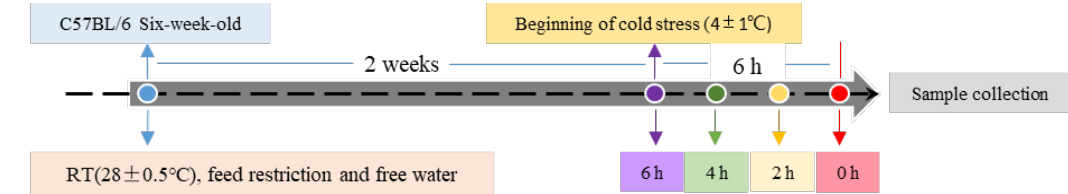
Figure 9. Timeline of the treatment protocol. Mice in the room temperature (RT) control group were left undisturbed, whereas cold mice were exposed to 4 °C.